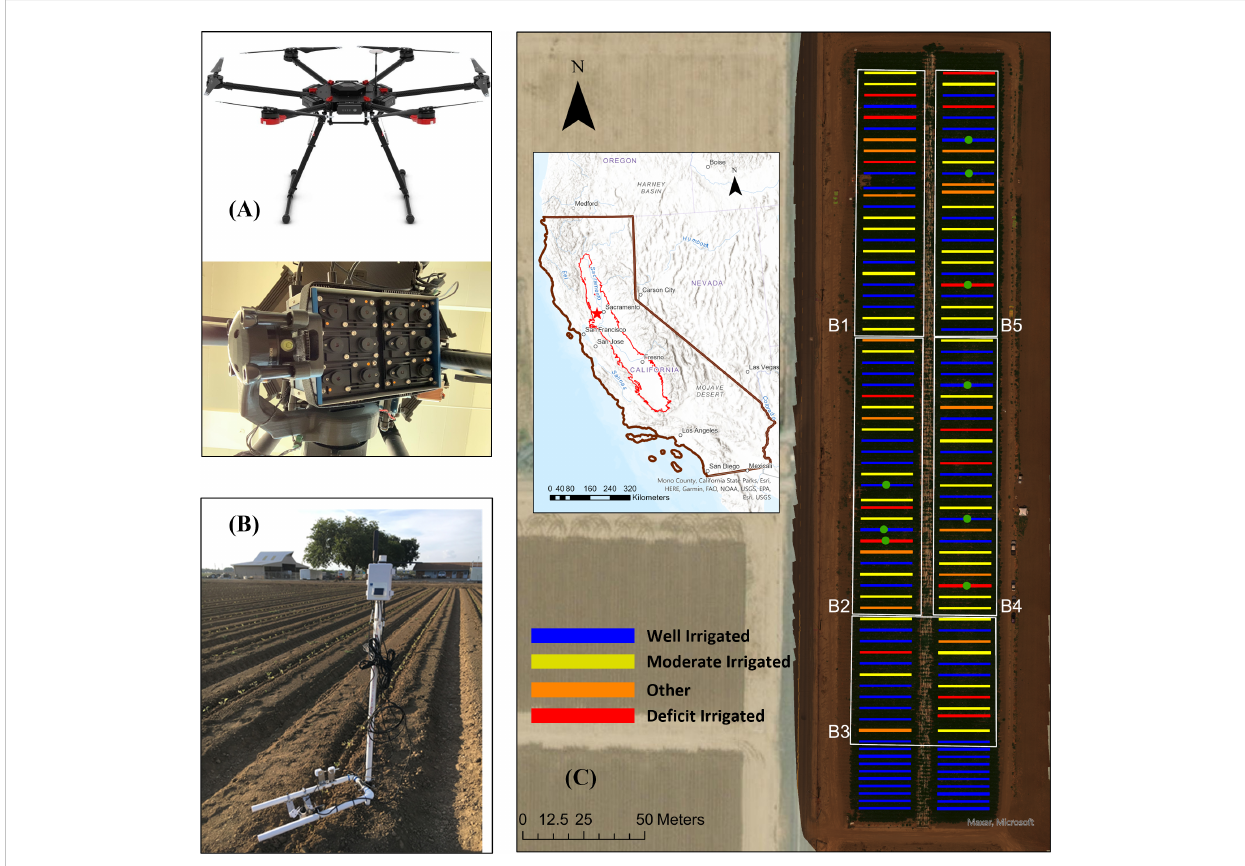
FIGURE 1 Study area (inset) and experiment design of the processing tomato fi eld in Davis, California. (A) Unmanned aerial vehicle (UAV) and multispectral camera used in this study. (B) Stands with proximal sensors installed in the fi eld. (C) The fi ve blocks (B1, B2, B3, B4, and B5) of the fi eld and the irrigation treatments of different plots. The block boundaries are shown as white polygons on top of the true color composite UAV imagery acquired on June 26, 2019. The blue, yellow, and red colors represent well, moderate, de fi cit and other irrigation treatments, where 100%, 70%, and 30% of actual evapotranspiration were applied to the plots between reaching full canopy (July 11, 2019) and irrigation cutoff (Aug 26, 2019), respectively. The locations of proximal sensors are shown as green